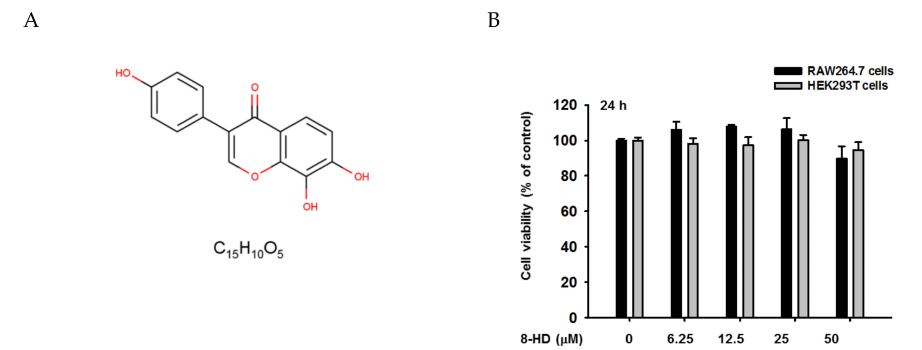
Figure 1. Chemical structure and viability profiles of 8-hydroxydaedzein (8-HD). ( A ) Chemical structure and a molecular formula of 8-HD. ( B ) RAW264.7 and HEK293T cells (10 5 cells / well) were treated with 8-HD at the indicated doses for 24 h, and cell viability was analyzed by a 3-(4,5- dimethylthiazol,2-yl)-2,5-diphenyltetrazolium bromide (atetrazole) (MTT)